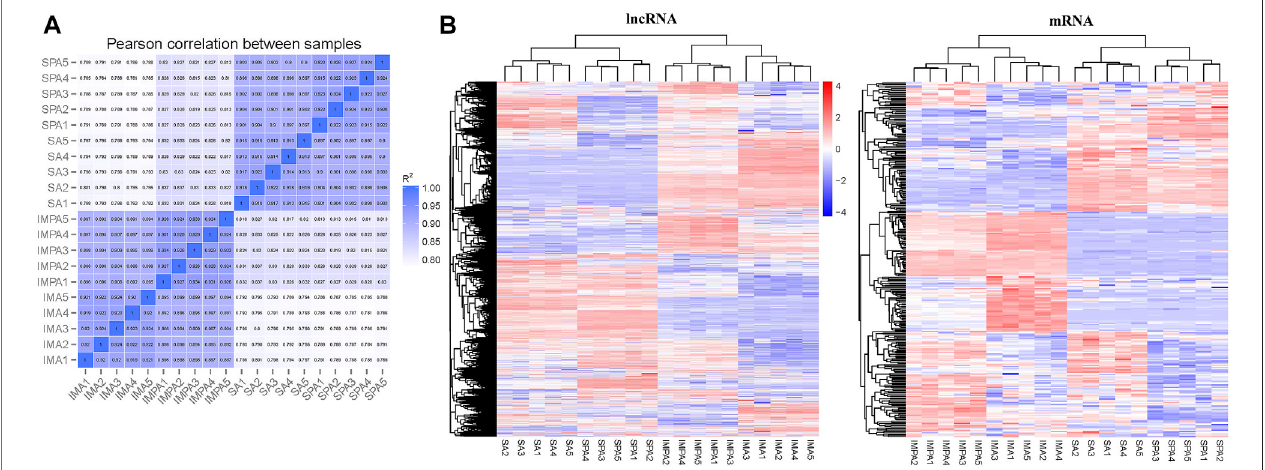
FIGURE 3 | Differentially expressed coding genes and lncRNAs in goat adipocytes between intramuscular and subcutaneous of differentiation (Fold Change ≥ 2 and P-adjust value ≤ 0.05). (A) Representativeofthe degree ofsimilarity between samples. The correlation coef fi cient is represented bycolor;deeper colorrepresentsa stronger correlation. (B) Clustering analysis of differentially expressed lncRNAs and mRNAs in IMA vs. IMPA and SA vs. SPA. Red means highly expressed genes and bluemeanslowexpressedgenes.Thecolorisfromredtoblue,whichmeanslog10(FPKM+1)fromlargetosmall. (C) PCAplotsofdifferentiallyexpressedlncRNAs and mRNAs in IMA vs. IMPA and SA vs. SPA. Scatter plots are drawn using principal component 1 and principal component 2 as the x- and y -axes. (D) Volcano plot of differentially expressed lncRNAs and mRNAs in IMA vs. IMPA and SA vs. SPA. Green and red represent downregulated and upregulated expression, respectively.